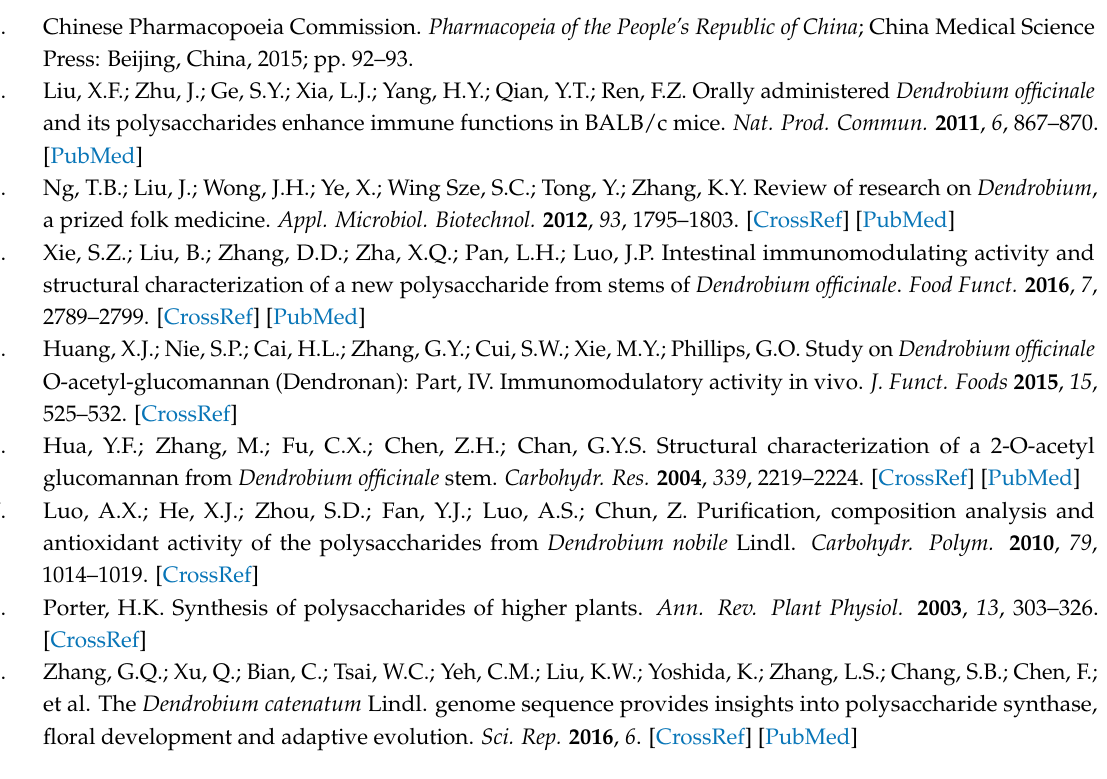
Figure S1 Prediction of transmembrane helices in SWEETs and SUT from D. officinale. Table S1 Summary of the differentially expressed genes between leaves and stems. Table S2 Summary of putative SWEETs in D. officinale